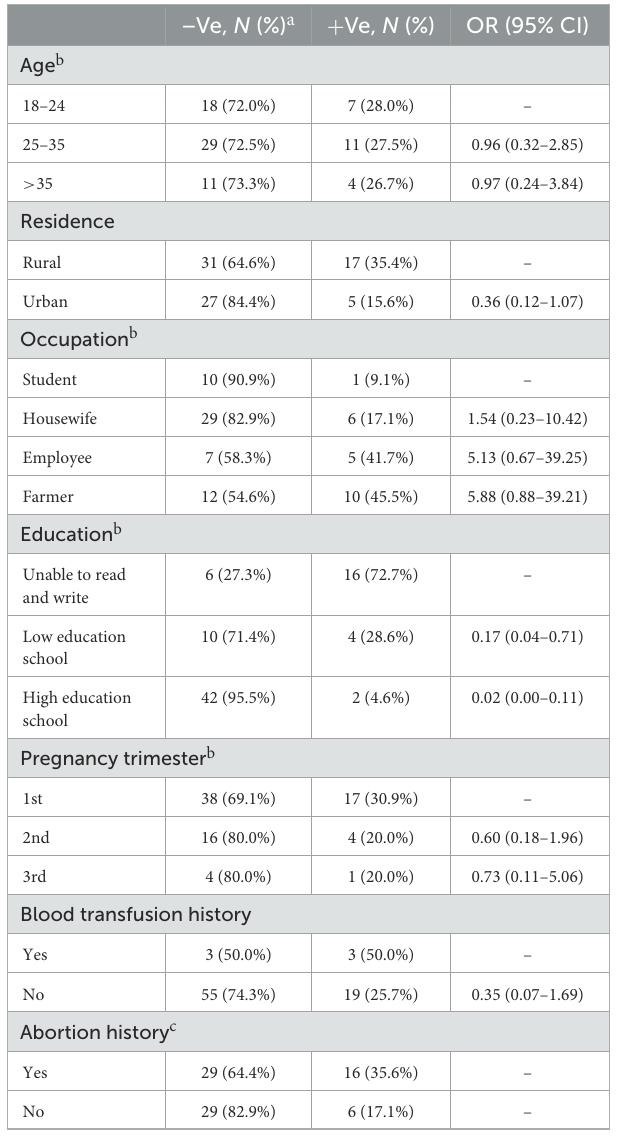
TABLE 1 Demographic characteristics of the enrolled women and univariable firth logistic regression